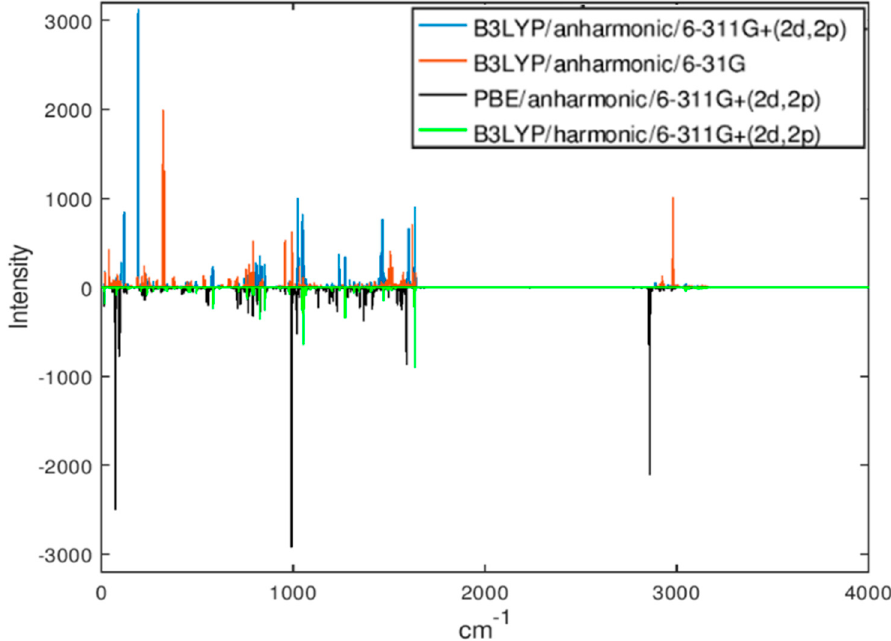
Figure 2. IR spectra of the A232 molecule computed with different levels of theory. Spectra are Gaussian broadened by 1 cm − 1 (Gaussian width). Some spectra are plotted in the negative for better visibility. The intensities are in 10 − 40 esu 2 cm 2 .